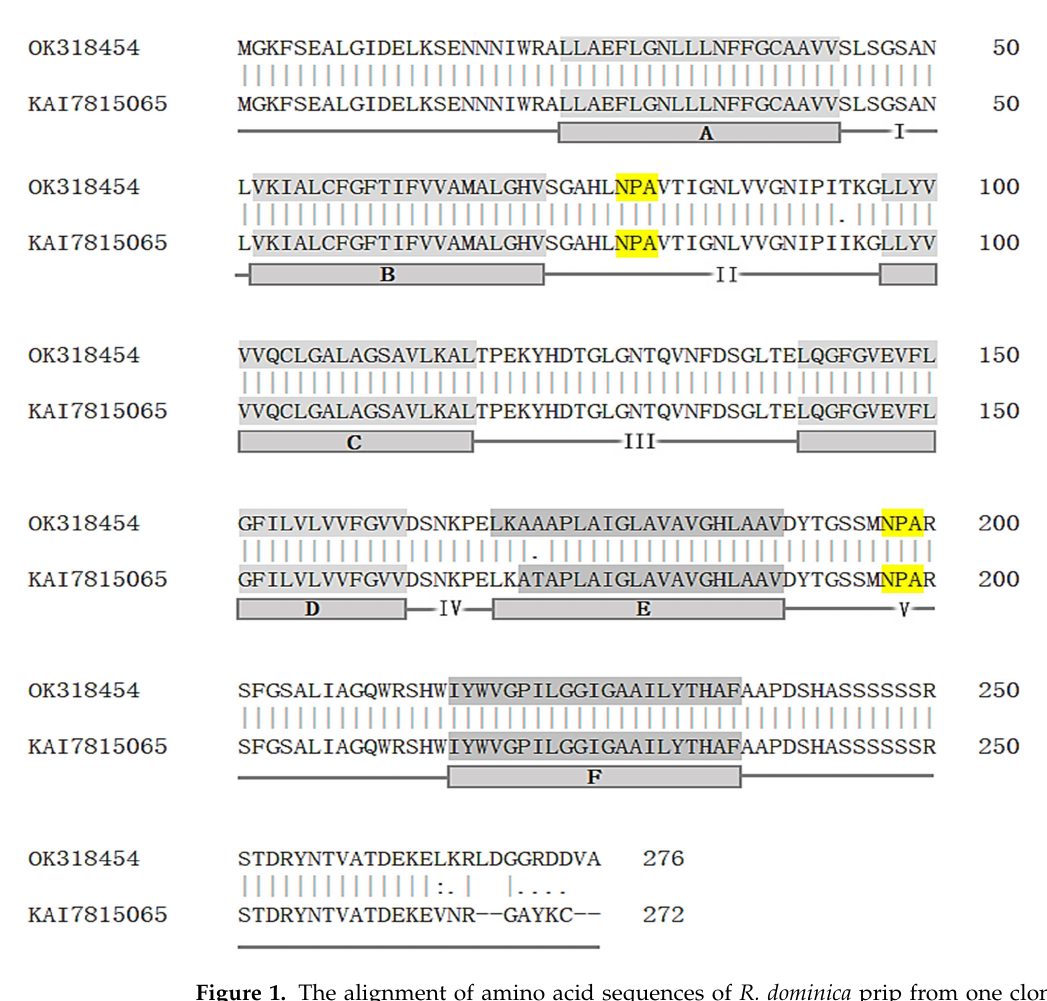
Figure 1. The alignment of amino acid sequences of R. dominica prip from one cloned from this study (Accession no. OK318454) and the other from the genome (Accession no. KAI7815065). The six transmembrane regions ( A – F ) are indicated by a gray background. The two NPA (Asn–Pro–Ala) motifs located on the second and fifth loops are marked in yellow. Insects 2023 , 14 , x FOR PEER REVIEW